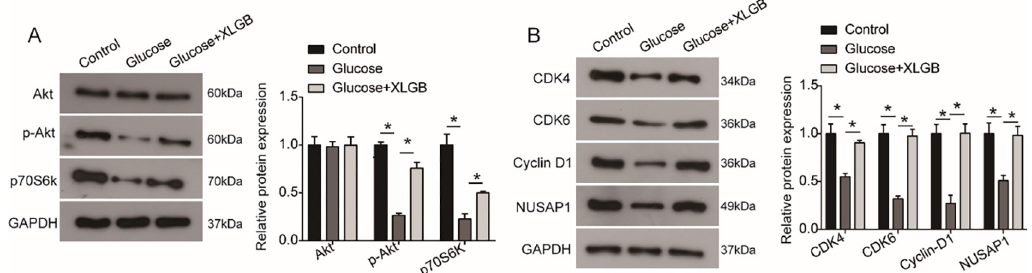
Fig 7. XLGB rescues the PI3K/Akt signaling pathway in MG63 cells down-regulated by high glucose. A. Western blot analysis was used to examine the protein levels of key components of the PI3K/Akt signaling pathway in MG63 cells after indicated treatment. B. The protein levels of cell cycle-related proteins (CDK4, CDK6, Cyclin D1) were detected by western blot analysis. Control, cells treated with mannitol; Glucose, cells treated with 20 mM of glucose; Glucose +XLGB, cells treated with 20 mM of glucose plus 200 mg/L of XLGB. Data represented mean ± SD of three separate experiments. � P <